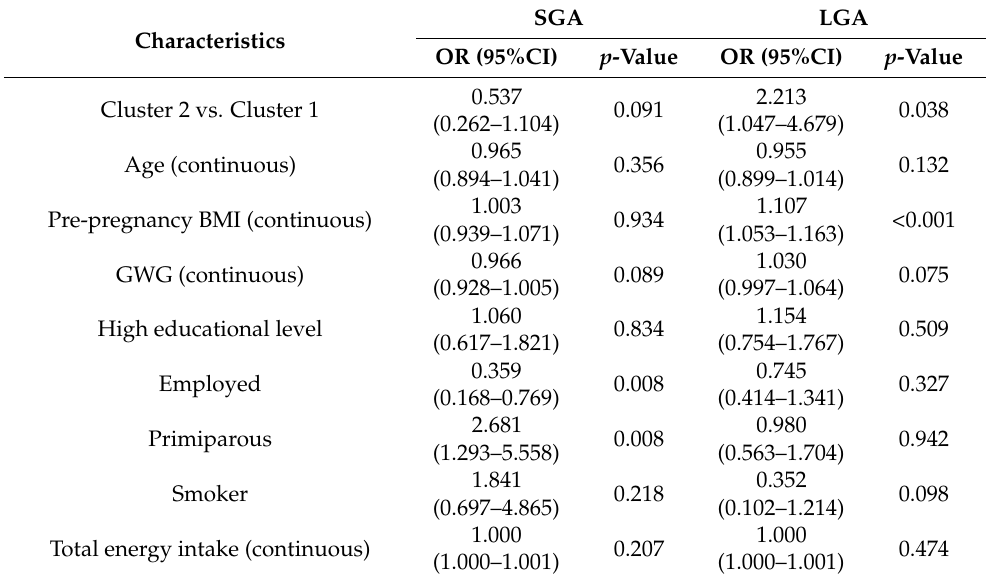
Figure 4. Distribution of birth weight for gestational age by clusters. Table 2. Factors associated with birth weight for gestational